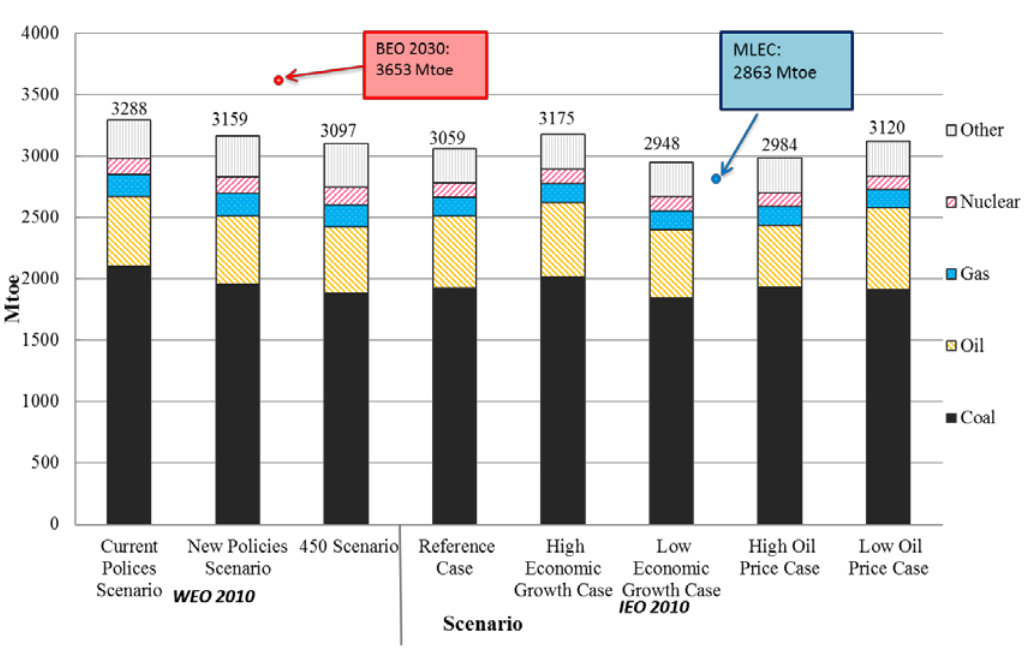
Figure 3. A comparison of projections of primary energy demand of China, 2020.